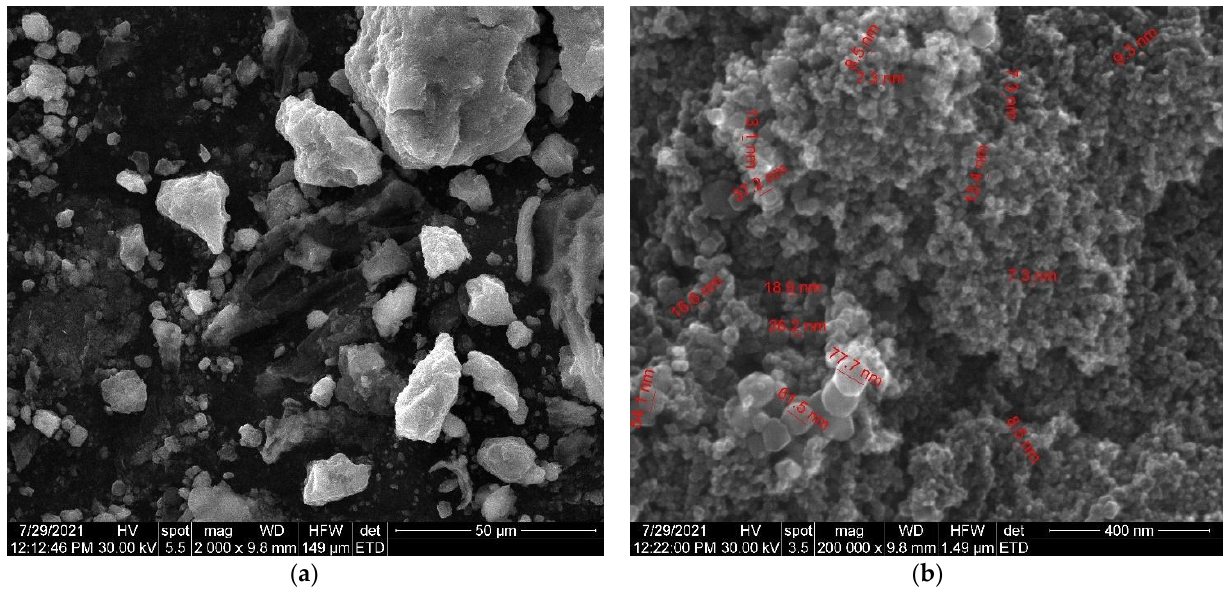
Figure 11. ( a ) SEM images of Fe 3 O 4 nanoparticles loaded with herb at high magnification. ( b ) SEM images of Fe 3 O 4 nanoparticles loaded with herb at low magnification.